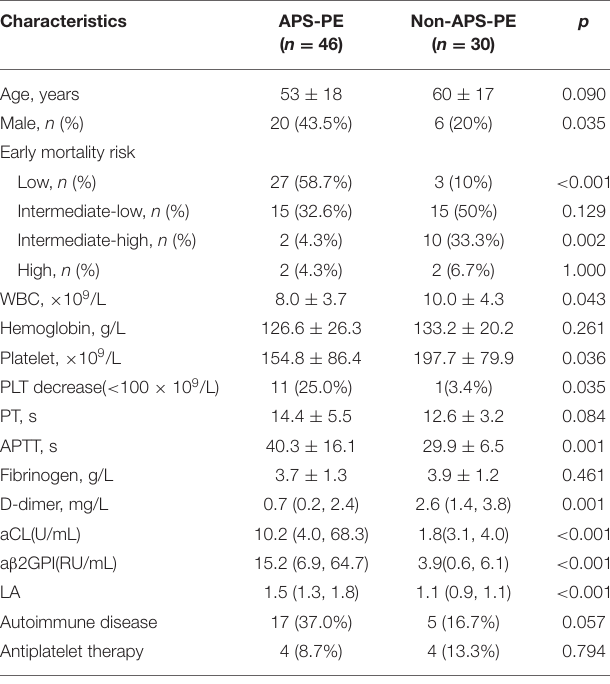
TABLE 3 | Comparison of clinical characteristics between the PE and VTE groups.